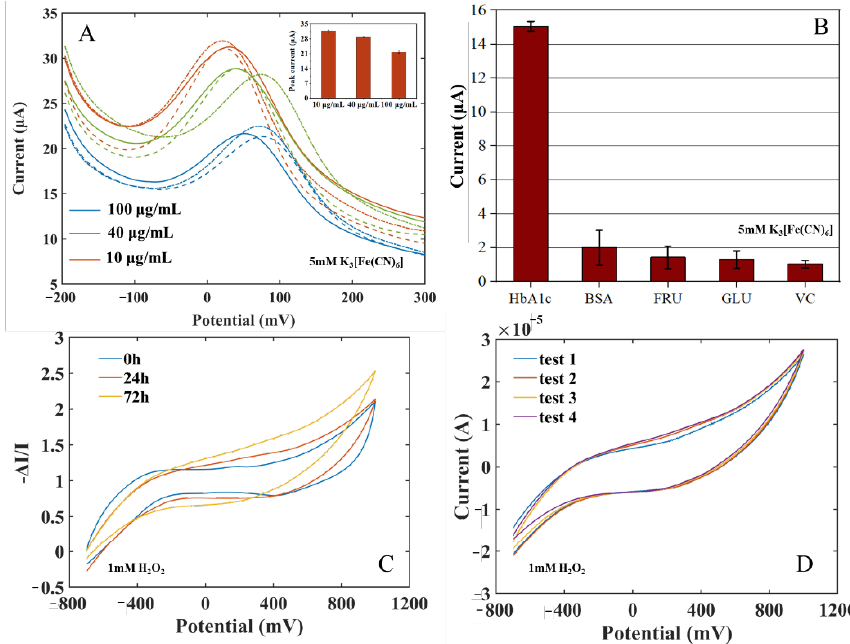
Figure 6. ( A ) Repeatability measurement: current of the immune electrodes to HbA1c of 10 μg/mL, 40 μg/mL, 100 μg/mL, and 150 μg/mL ( insert: peak current comparison) . ( B ) Specificity measurement: current of the immune electrodes to HbA1c, BSA, GLU, FRU, and VC. ( C ) Long-term measurement: 0 h, 24 h, 72 h. ( D ) Repeated experiments at 72 h.